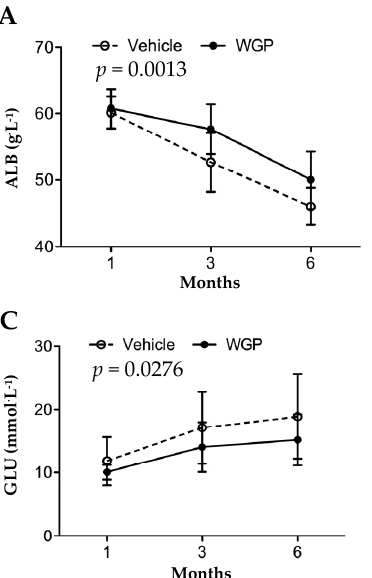
Figure 2. Daily intake of WGP has beneficial effect on the maintenance of blood albumin and the reduction of blood glucose in obese diabetic ZSF1 rats. The blood levels of albumin (ALB), globulin (GLOB) and glucose (GLU) were measured in randomly selected rats in Vehicle ( n = 8–12) or WGP ( n = 8–11) group after one, three or six months of dietary supplements. Data were presented as mean ± SD of each group. ( A ) Blood ALB levels. Vehicle vs. WGP: p = 0.0013 (two ‐ way ANOVA); ( B ) ALB/GLOB ratio. Vehicle vs. WGP: p = 0.0092 (two ‐ way ANOVA); ( C ) Blood GLU levels. Vehicle vs. WGP: p = 0.0276 (two ‐ way ANOVA).